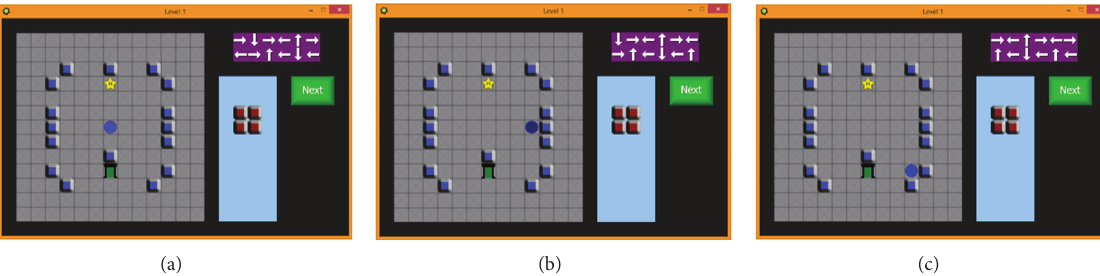
Figure 4: Screenshots from Game F that show the ending position of the orb after the player clicks the action button. From left to right: the starting position, after one movement right, and after one movement down.